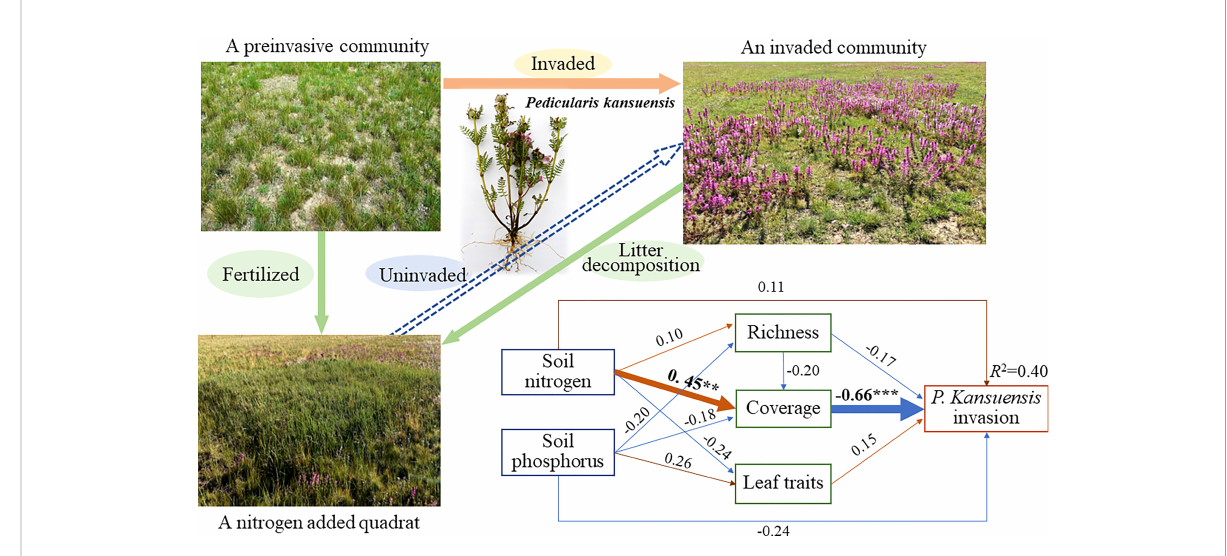
FIGURE 4 A schematic diagram showed the invasion process of P. kansuensis . Structural equation model for P. kansuensis invasion (aboveground biomass of P. kansuensis ) of the fertilization experiment, is shown in the lower right panel and is based on the effects of soil nitrogen, soil phosphorus, species richness, coverage of sample communities excluding P. kansuensis (Coverage), community-weighted mean trait values (leaf traits). c 2 = 0.176, Df = 3, P = 0.981, CFI = 1.000, TLI = 2.003, RMSEA < 0.001, AIC = 48.176. Single-headed arrows indicate the hypothesized direction of causation. Orange and blue arrows indicate positive and negative relationships, respectively. The arrow width is proportional to the strength of the relationship. The numbers adjacent to arrows are standardized path coef fi cients, which re fl ect the effect size of the relationship. R 2 (coef fi cient of determination) indicates the proportion of variance explained by the relationship. Signi fi cance levels are as follows: **P < 0.01, ***P <